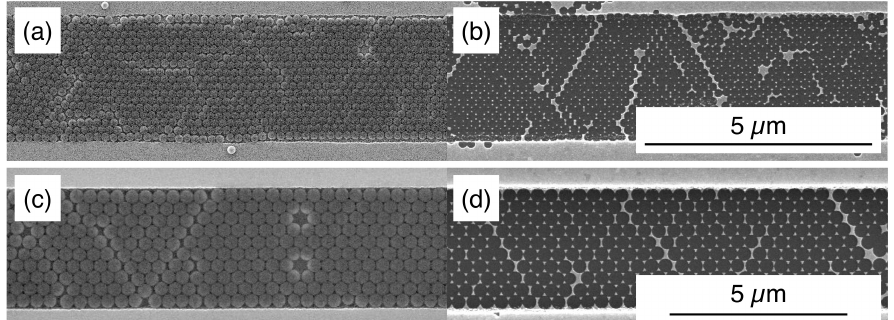
Figure 8. NSs with different sizes—( a ) 200nm and ( c ) 400nm—are confined in a monolayer inside linear templates where the ratio H/D is kept constant at 0.6. This lithographic mask can be used for the realisation of arrays of gold nanotriangles ( b , d ) with tunable dimensions to match the excitation wavelengths for the sensing of different SERS-active analyte